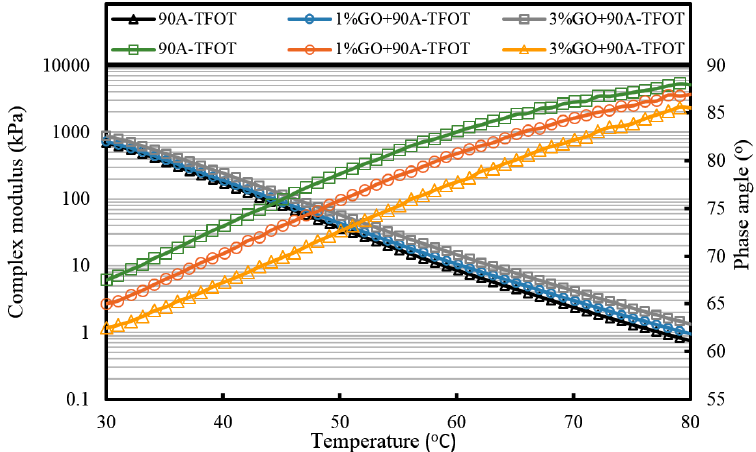
Figure 11. Complex modulus and phase angle of GO-modified 90A and its matrix at high temperature after TFOT aging.